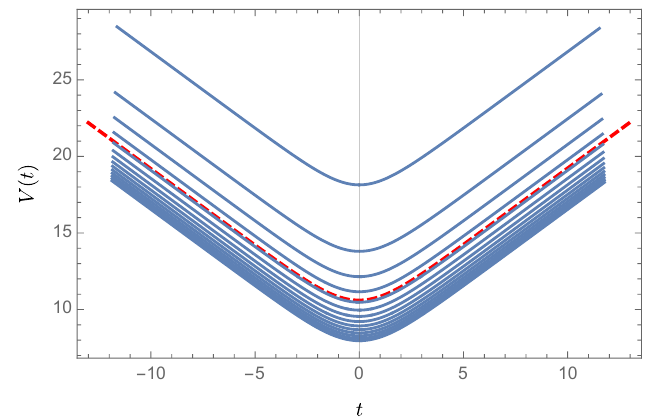
Figure 12. Volume as a function of boundary time t for the different AdS-to-AdS geometries with R b = 100 and φ 0 = 2 . The curves go from α = − 1 . 9 at the top to α = 5 at the bottom, in steps of 0.5. In all cases, for long times, the behaviour is linear with the same slope. In dashed red, we show the curve for the AdS black hole, corresponding to the case α = 0